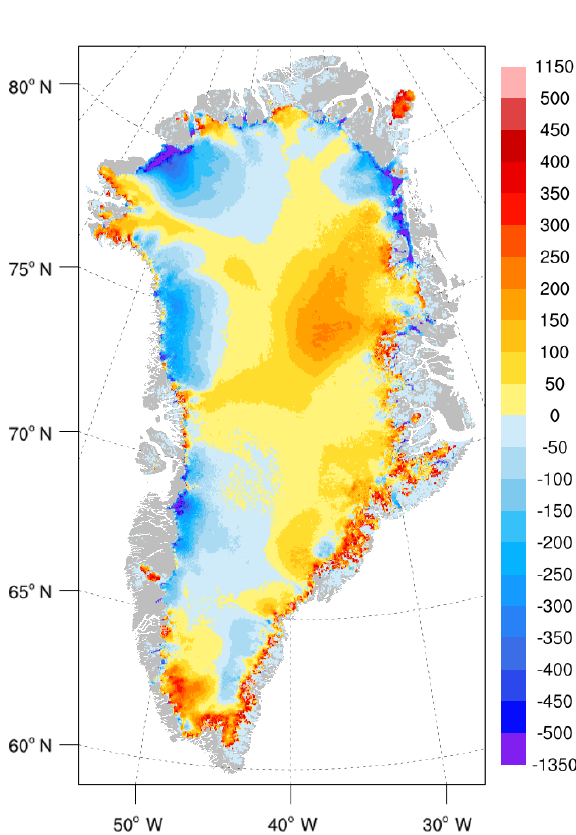
Figure 12. Basal water state at the end of a 50kyr Greenland spin- up. Red: fully saturated bed with basal water depth W capped at the upper limit of 2m. Light blue: partly saturated bed with 0 < W < 2m. Dark blue: frozen bed with W = 0. The color scale is based on Fig. 11 of MacGregor et al. (2015). The gray background shows ice-free